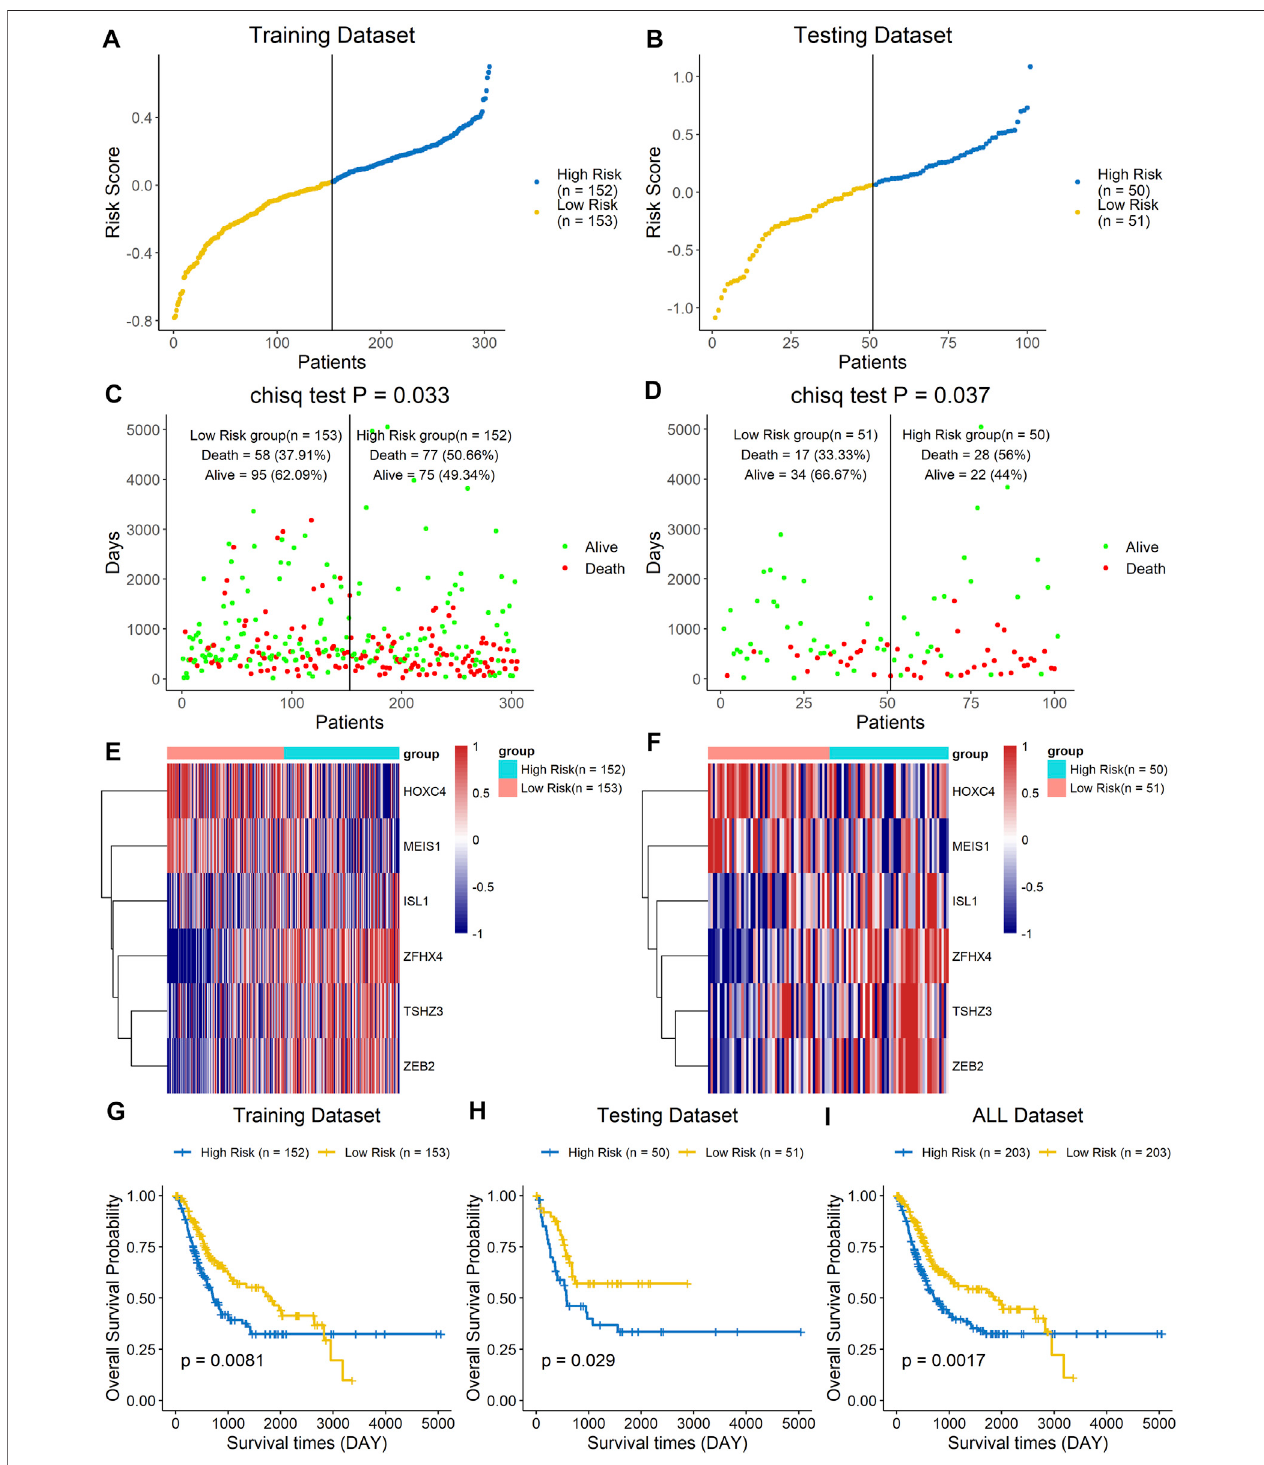
FIGURE 4 | A high risk score was associated with a poor clinical outcome. The BLCA cohort was divided into two groups based on the median estimated score, and the two groups were then compared. The ranked dot plot indicates the risk score distribution in the training dataset (A) and testing dataset (B) . Scatter plot presenting the patients ’ overall survival status in the training dataset (C) and testing dataset (D) . Heat map with the gene expression pro fi les of these six genes in the training dataset (E) and testing dataset (F) . Kaplan – Meier curve analysis of the signature in the training set (G) , testing set (H) , and entire dataset (I) .